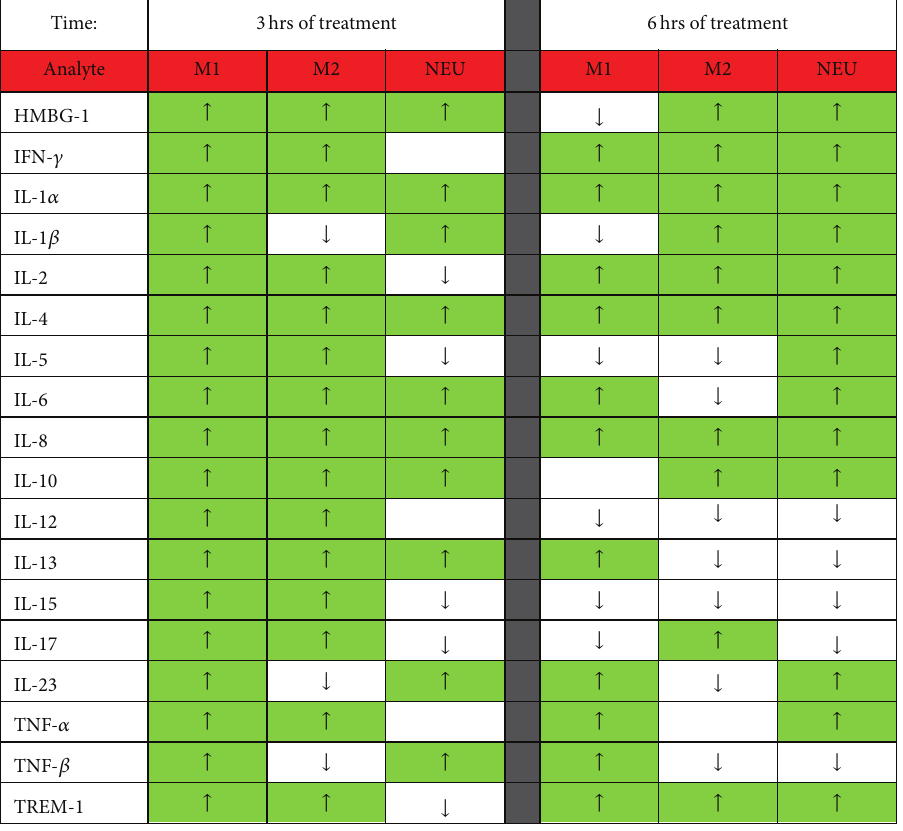
Figure 6: Inflammatory protein mediator heat map analysis of innate immune cells in response to peritoneal fluid (PF) from septic swine in vitro . The production of 18 different inflammatory proteins by human M1 and M2 macrophages and neutrophils (NEU) was induced in vitro with PF from swine taken at 3 hrs and 6hrs intervals following initiation of treatment for septic injury induced at 𝑇 0 . Arrows indicate direction of response T-C (T = NPT; C = SOC). Green boxes highlight where T >